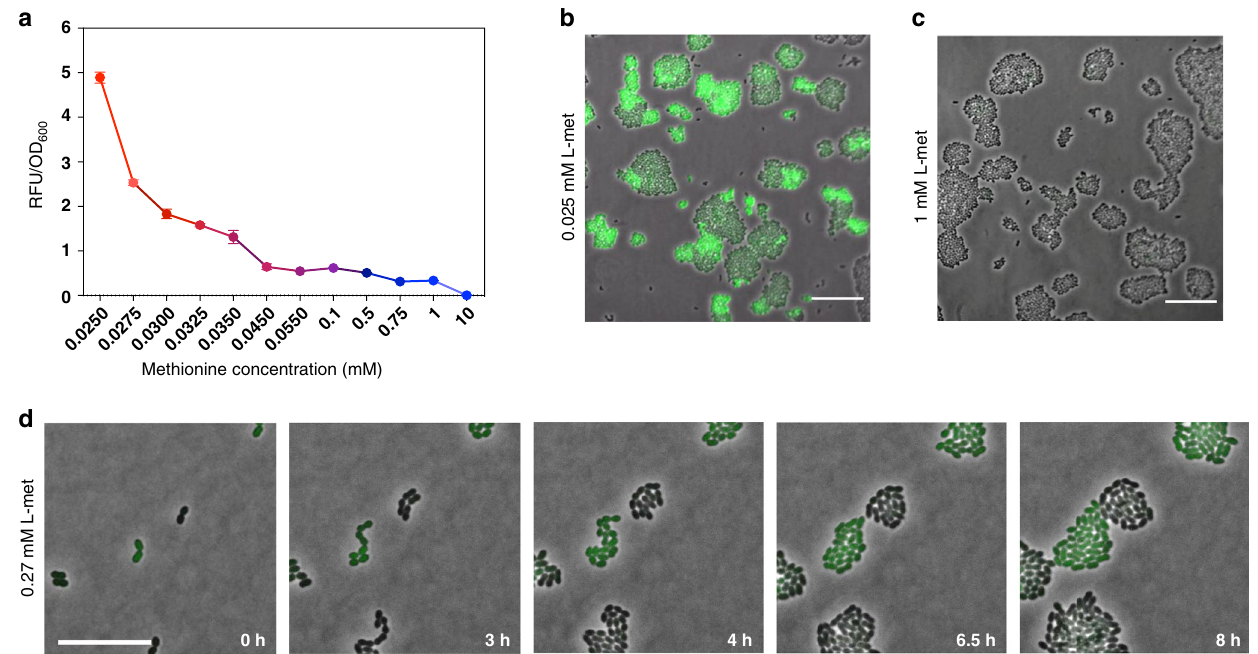
Fig. 1 The Met-transporter is heterogeneously expressed at low methionine concentrations in L. lactis . a Expression of the Met-transporter at the population level in cultures of the L. lactis Pmet-gfp strain, grown in CDM supplemented with increasing concentrations of methionine (0.025 mM to 10 mM). Data are presented as mean ± S.D. Error bars represent standard deviation (SD) of the mean values of three independent experiments. Source data are provided as a Source Data fi le. b Two phenotypes coexist when L. lactis Pmet-gfp is grown in standard CDM containing methionine at concentration of 0.27 mM. Snapshots of a time-lapse fl uorescence microscopy experiment, where the GFP + cells (green cells) re fl ect high met expression and the GFP − cells (black cells) show low met expression. Scale bar, 15 µ m. c , d Snapshots of single-cell fl uorescence microscopy, when the cells are grown in CDM with low and high methionine concentrations (0.025 and 1 mM) respectively (Supplementary Movies 2 and 3). Overlays of green- fl uorescence and phase-contrast images are shown. Scale bars, 15 µ